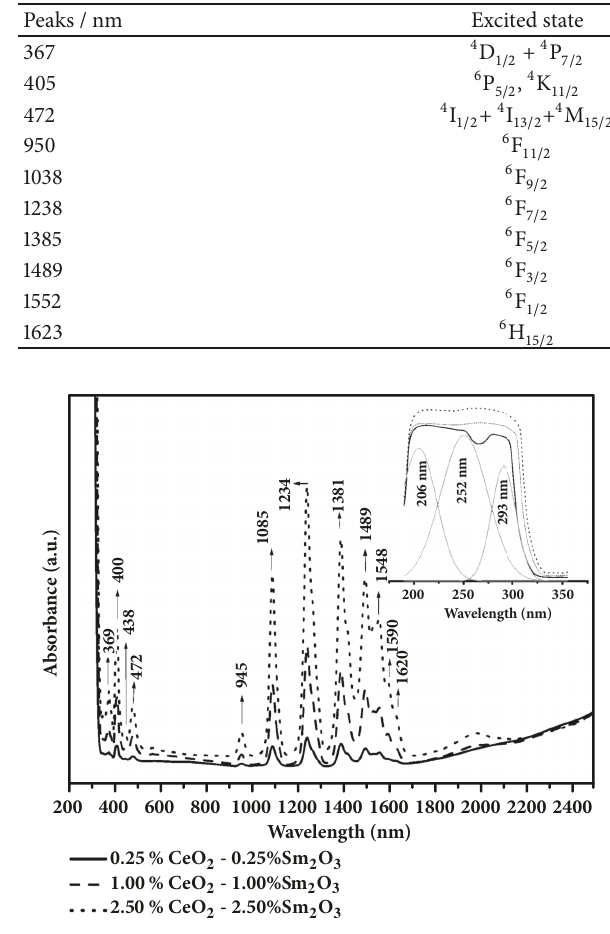
Figure 4: Optical absorption spectra of CeO 2 + Sm 2 O 3 -doped glasses with attached deconvoluted spectrum (UV